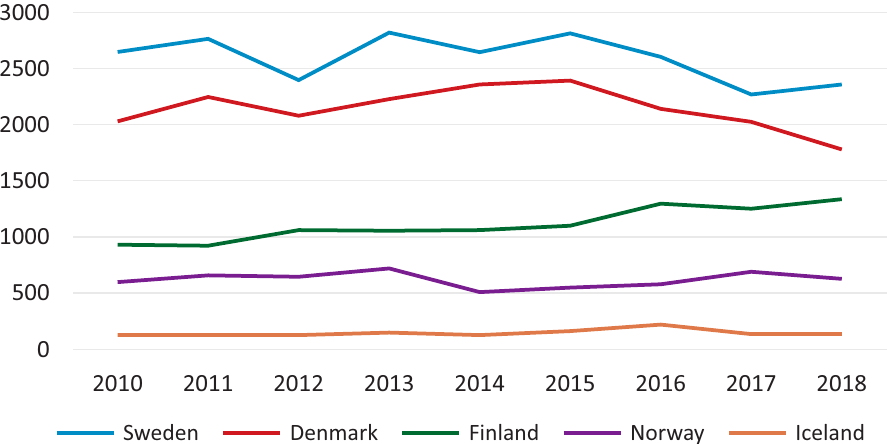
Figure 1. Number of Nordic citizens moving to the UK according to the national statistics data of each sending country, 2010–2018. Sources: Statistics Denmark (2019), Statistics Finland (2019), Statistics Iceland (2019), Statistics Norway (2019), and Statistics Sweden